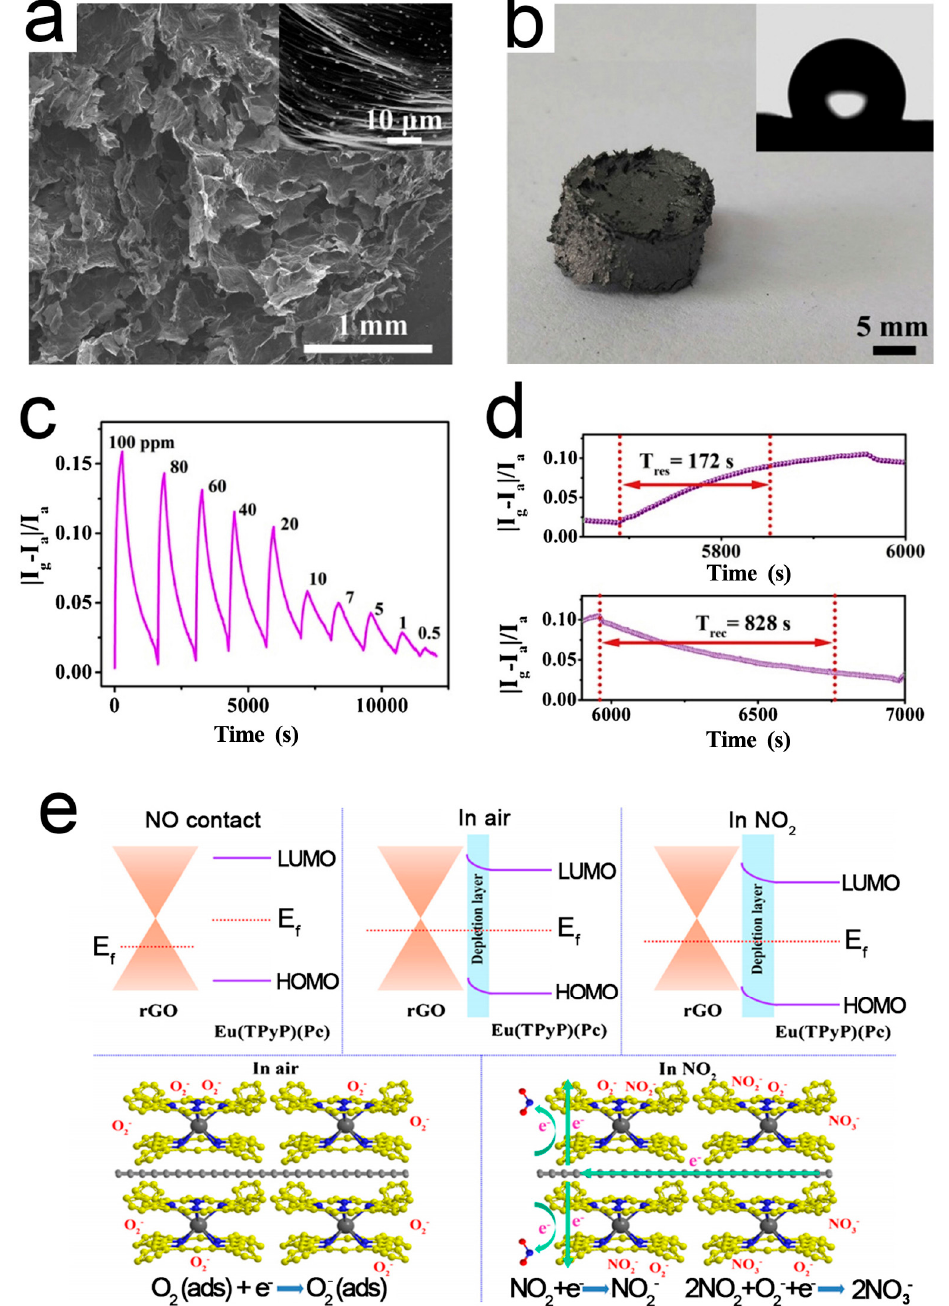
Figure 4. ( a ) SEM image of RGO/Eu(TPyP)(Pc); ( b ) Photograph of RGO/Eu(TPyP)(Pc); inset: water contact angle. ( c ) Dynamic responses of RGO/Eu(TPyP)(Pc) to NO 2 ; ( d ) Response-recovery time of RGO/Eu(TPyP)(Pc) to 20 ppm NO 2 ; ( e ) Working mechanism of the RGO/Eu(TPyP)(Pc) sensor